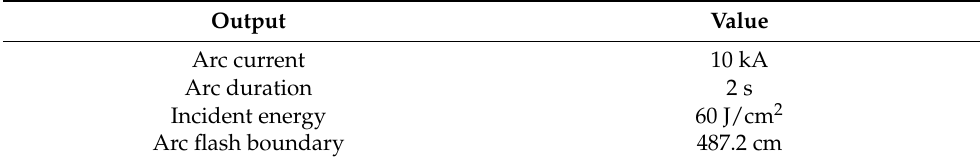
Table 11. ArcPro simulation results summary—Case study 5.